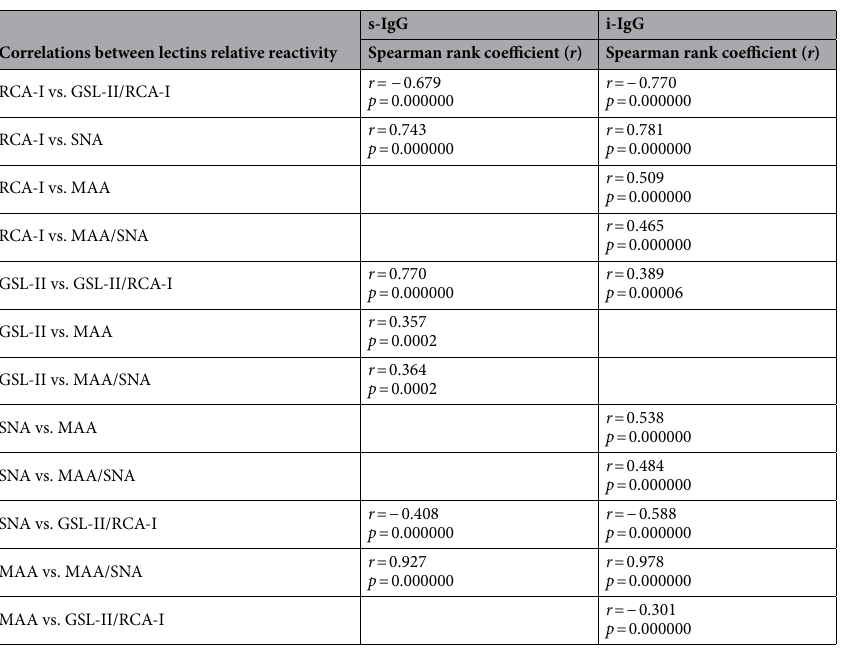
Table 2. The correlations between relative reactivities of IgG glycans with lectins. Serum native IgG—s- IgG; serum IgG isolates—i-IgG. MAA: Maackia amurensis agglutinin, recognizing sialic acid α2,3-linked; SNA: Sambucus nigra agglutinin, recognizing sialic acid α2,6-linked; GSL-II: Griffonia simplicifolia lectin II, recognizing terminal GlcNAc; RCA-I: Ricinus communis agglutinin I, recognizing terminal Gal. A two-tailed p -value of less than 0.05 was considered as